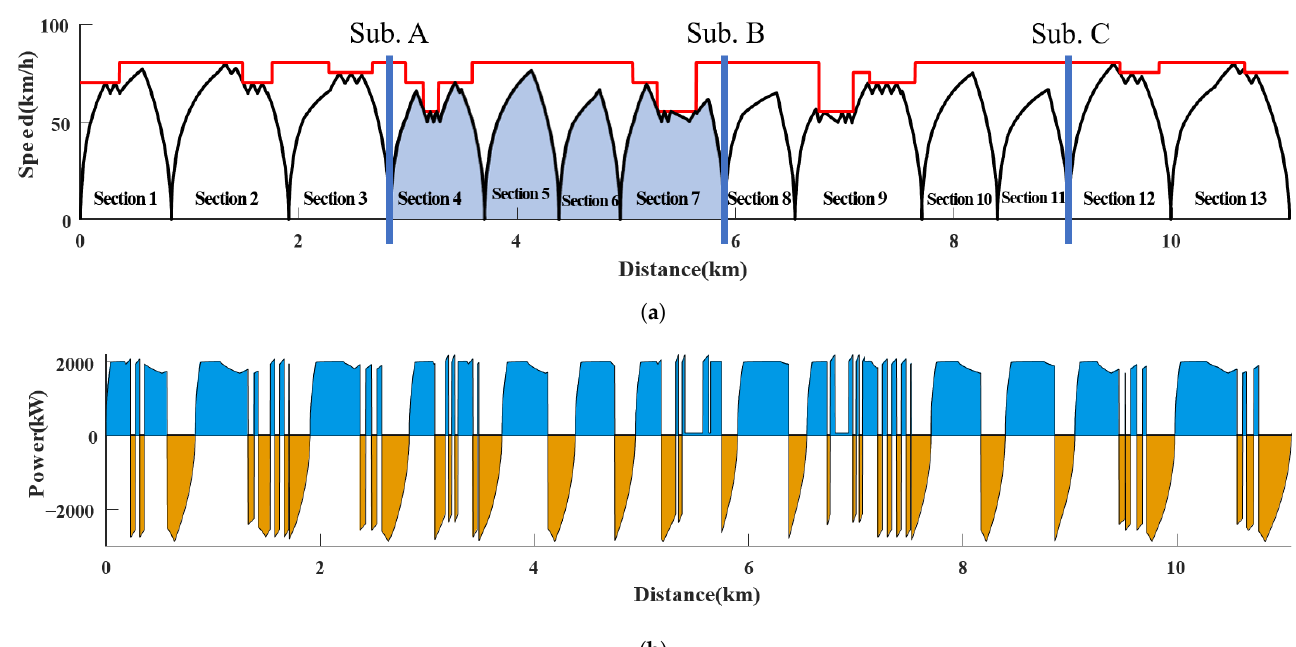
Figure 9. mTPS result for train dynamic representation. ( a ) Distance versus speed curve for DC metro line and substation location. ( b ) Distance versus traction and breaking power